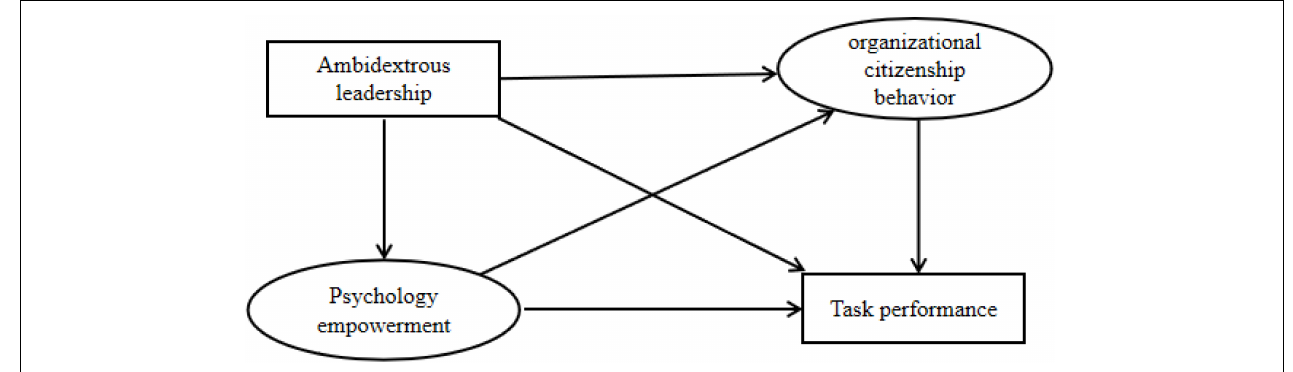
FIGURE 1 | Hypothetical